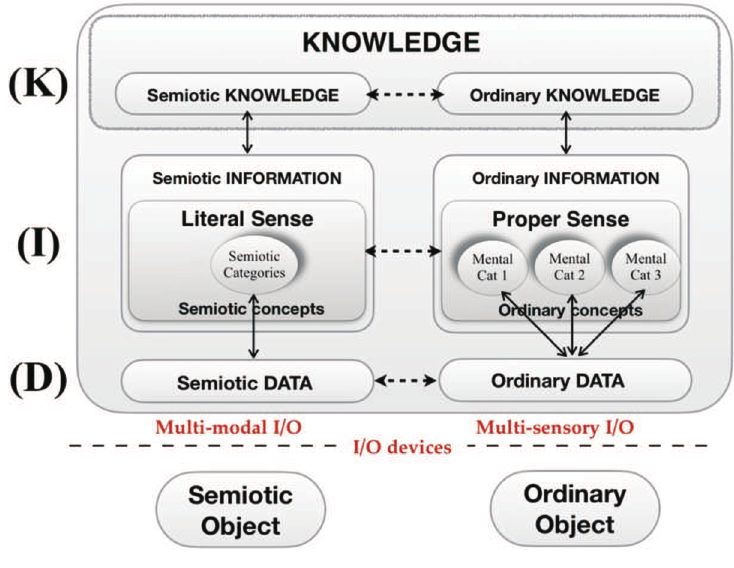
Figure 3. Relations between the multi-modal and multi-sensory Data (D), the Literal and Proper Senses (I) and the integrated semiotic and ordinary Knowledge